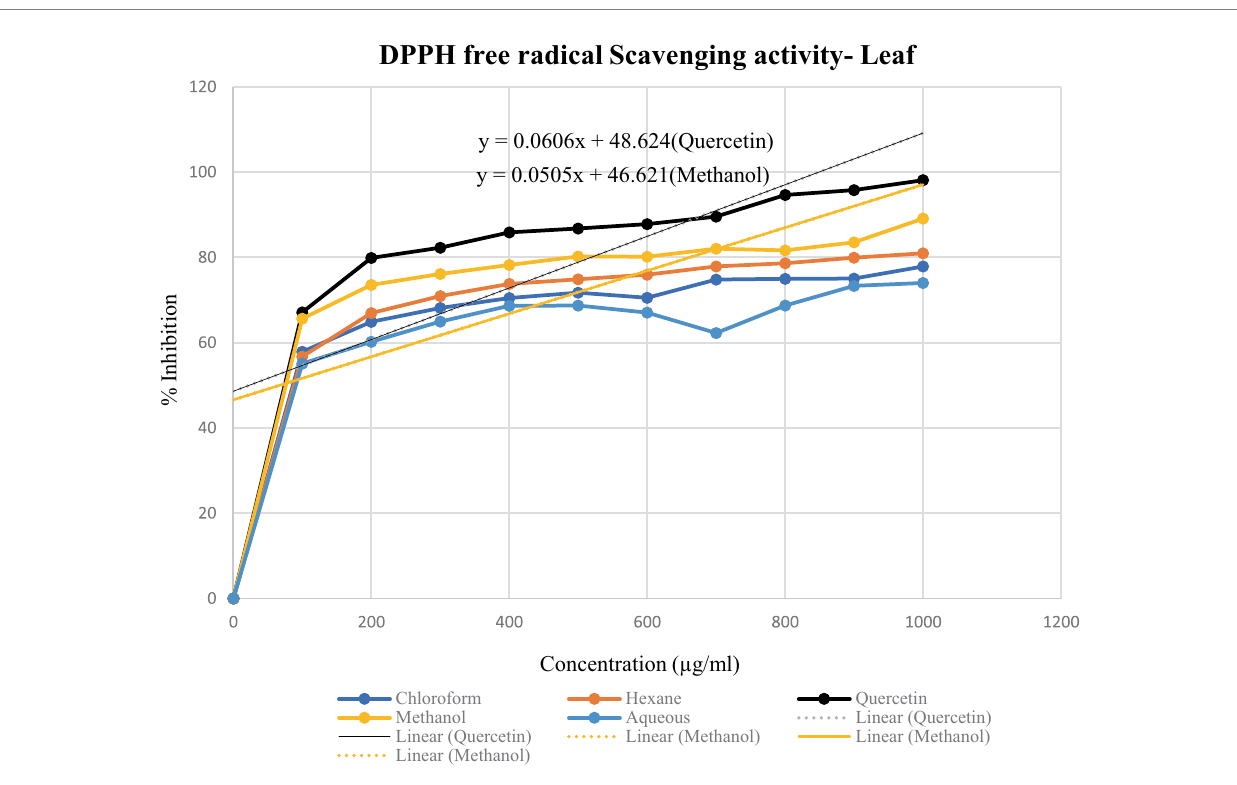
FIGURE 5 Graphical representation of T. cordifolia leaf for the percentage of inhibition of various